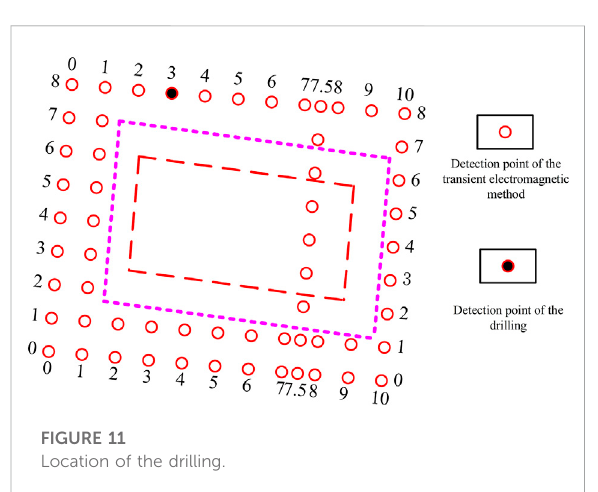
FIGURE 13 Core rate and the apparent resistivity at point 3 of the Y 3